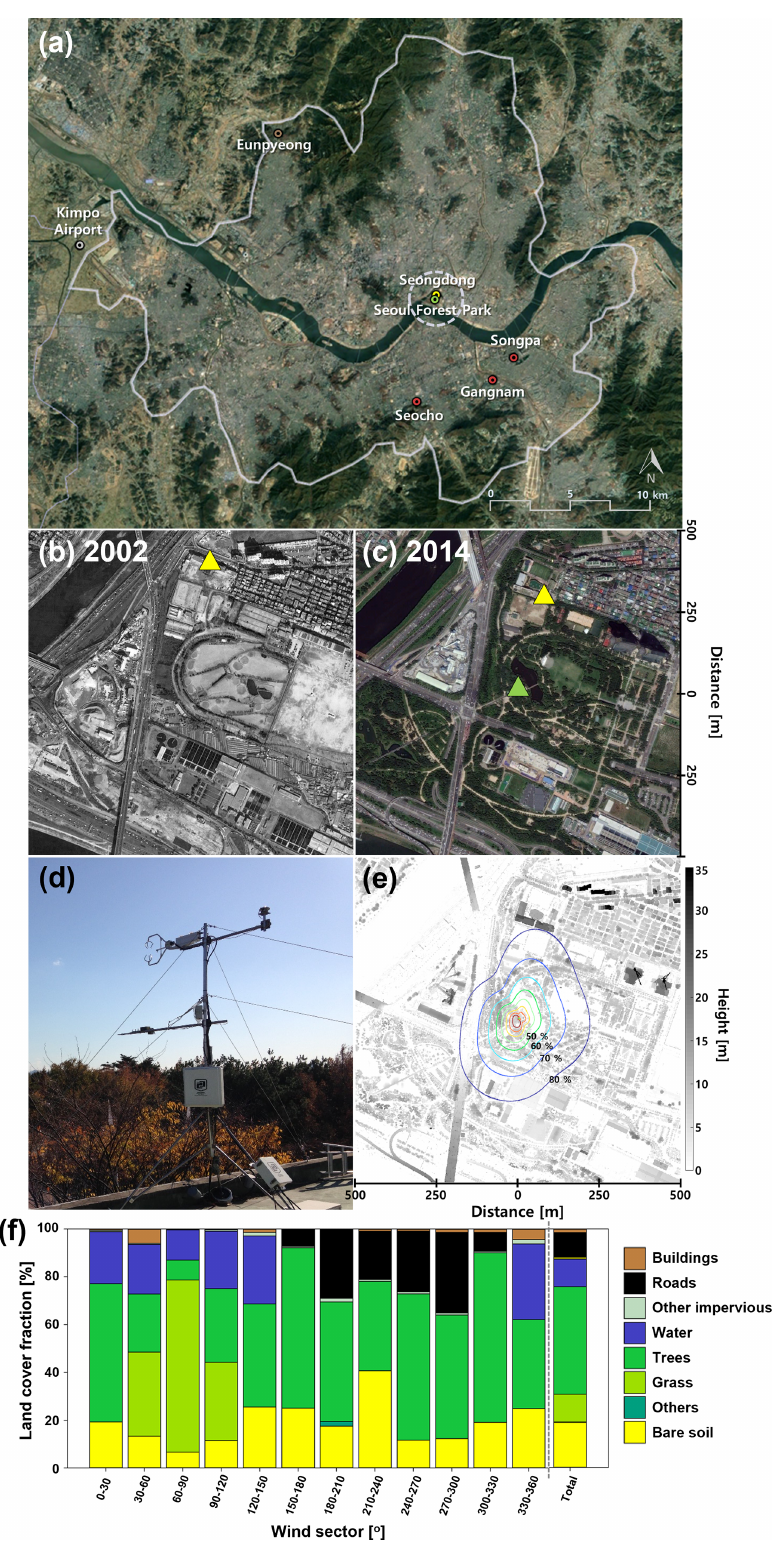
Figure 1. Site descriptions. (a) Location of the stations in Seoul (modified from map data © Google Earth 2019), (b) aerial photographs around Seoul Forest Park (SFP) in 2002 before the creation of the park and (c) in 2014 during the observation period (SFP, green triangle; SD, yellow triangle), (d) photograph of the SFP station, (e) footprint climatology (Hsieh et al., 2000) with the height of obstacles around the SFP station, and (f) land cover fraction within a 150m radius around the flux